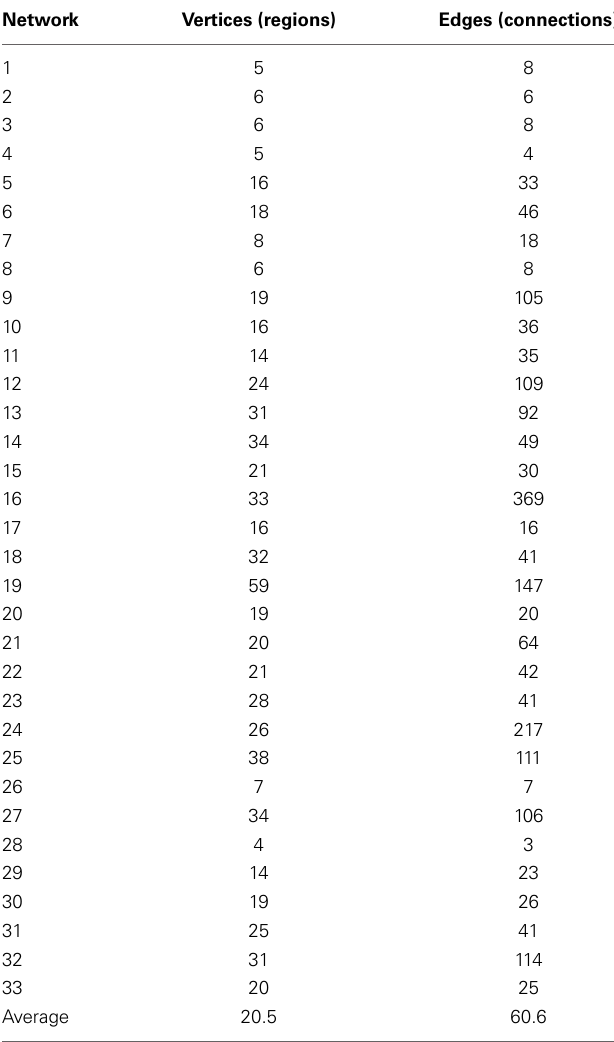
Table 1 | Descriptive information of connectivity networks (Figure 3).